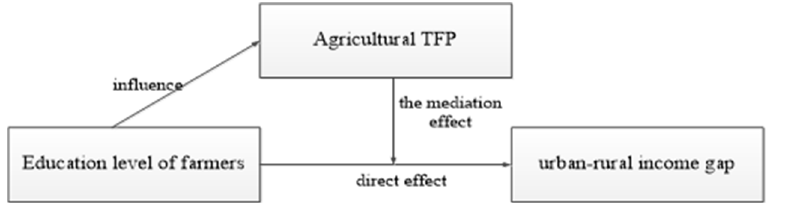
Figure 1. The effect of farmers’ education level on the rural–urban income gap based on the medi- ating effect of agricultural TFP. effect of agricultural